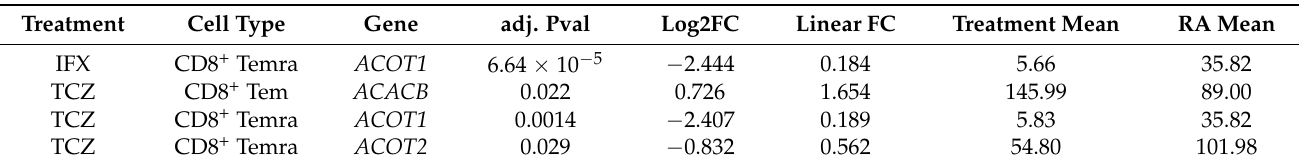
Table 12. Fatty acid metabolism DEGs in treated RA T cell subsets. Means are calculated from DESeq2 normalized